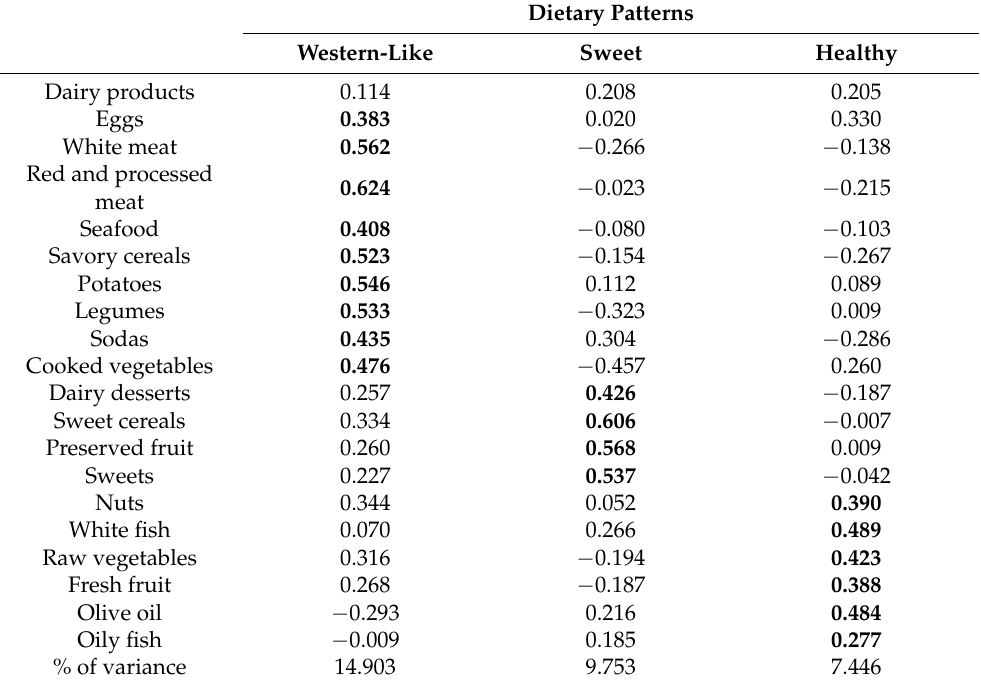
Table 2. Factor-loading matrix for three dietary